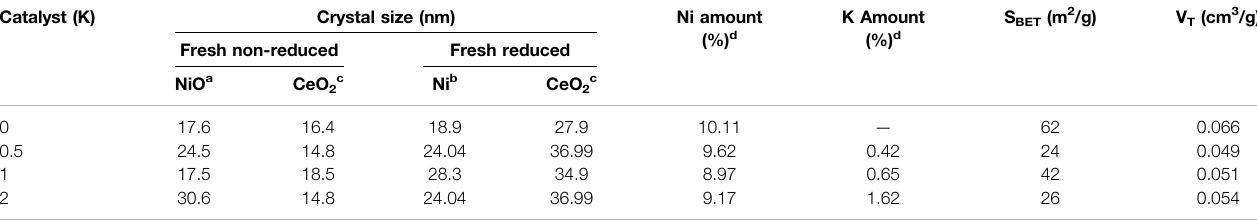
TABLE 2 | Textural properties of the catalysts. Catalyst (K)